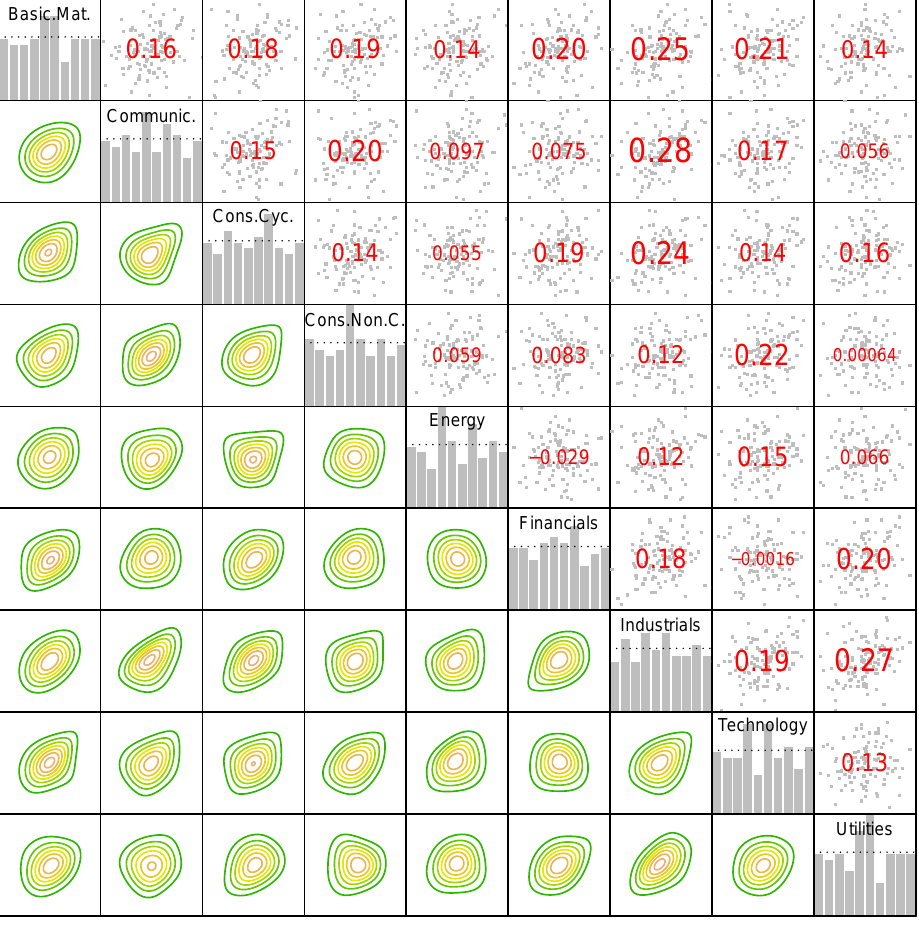
Figure 3. Upper triangular matrix: scatter plots with standard normal margins and Kendall’s τ values between pairs of aggregated sectors. Lower triangular matrix: contour plots of densities of pairs of aggregated sectors based on empirical copulas and standard normal margins. Diagonal: histograms of marginals after transformation to the copula